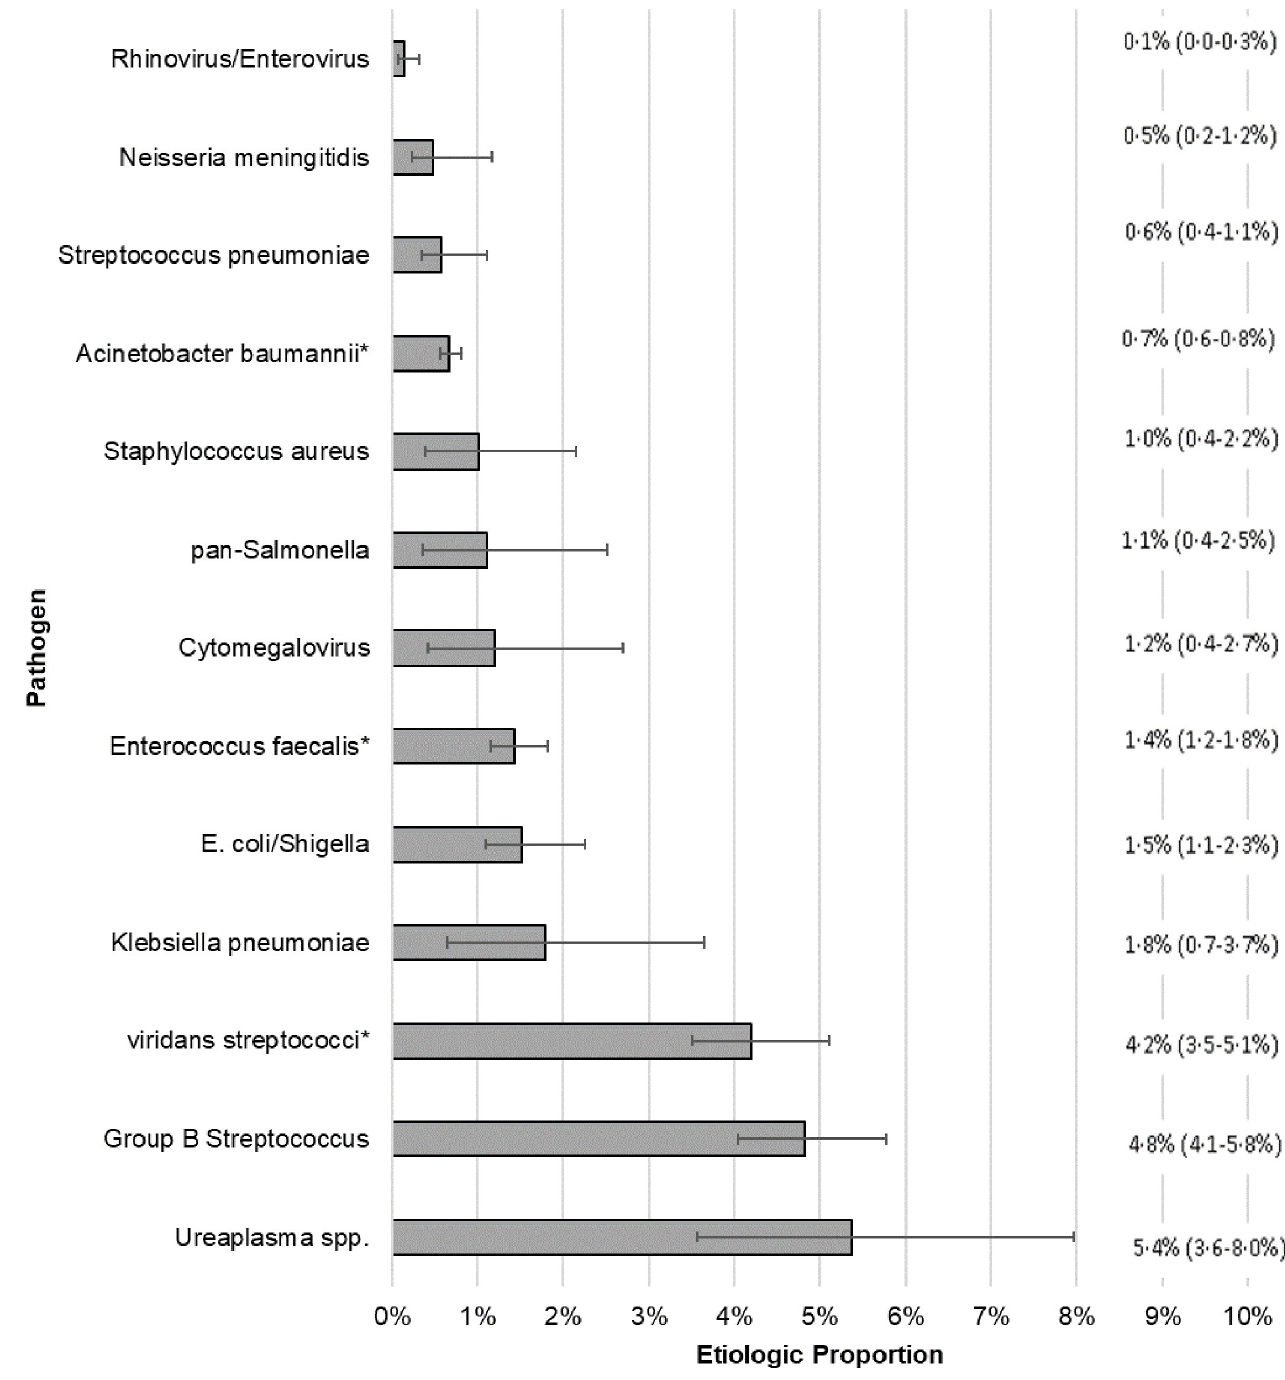
Fig 2. Estimated proportion of total cases caused by each pathogen with 95% confidence interval; Legend: � Pathogen proportion estimated indirectly from the “other blood culture” class. Footnote: 73.3% (68.2–77.2%) of case episodes could not be attributed to an evaluated pathogen